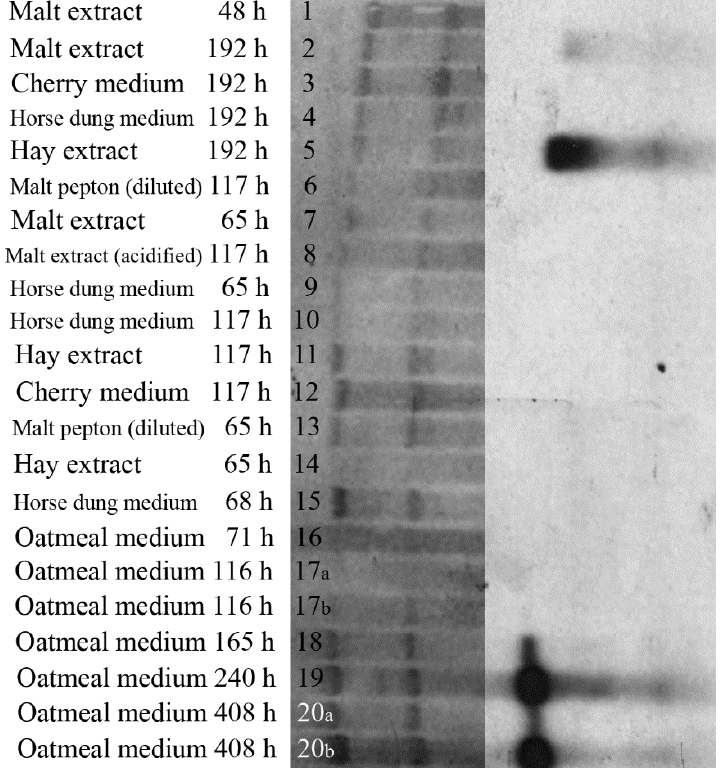
Figure 4. Expression of the ICARUS Gene. T. macrosporus has been cultivated on a large numbers of different growth media. The left part of the blot indicates the different amounts of ribosomal RNA present; the right part indicates the ICARUS positive expression signals that are observed after growth on the media designated with the labels 2, 5, 18, 19, 20a and 20b. These are all samples of cultures that show ascomata (fruit body) formation.